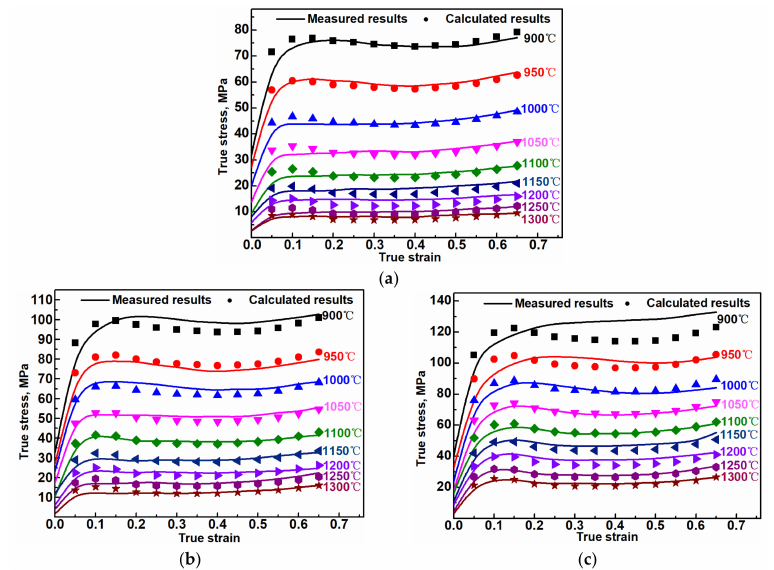
Figure 6. Comparison between the measured and the calculated results at different temperature and strain rate of ( a ) 0.001 s − 1 , ( b ) 0.01 s − 1 , and ( c ) 0.1 s − 1